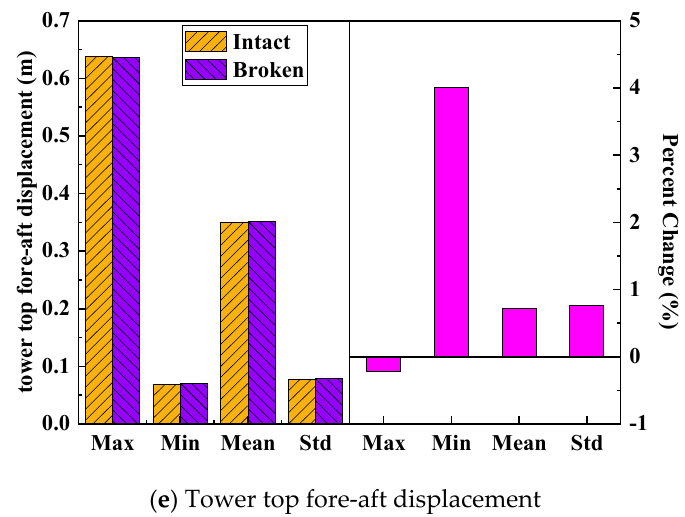
( e ) Tower top fore-aft displacement Figure 17. Comparison of dynamic response statistics and percent change. Figure 17. Comparison of dynamic response statistics and percent